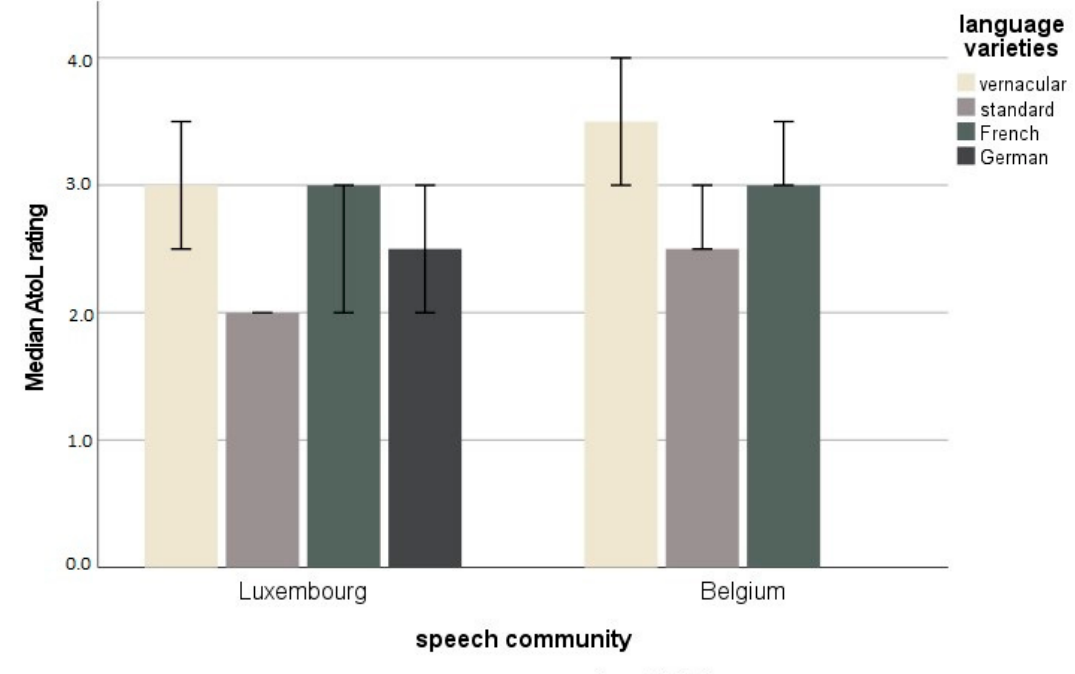
Figure 5. Between-speech community comparisons: Luxembourg (LUX) and Belgium (BELG). Vernacular (LUX: median = 3.00; BELG: median = 3.50). standard* (LUX: median = 2.00; BELG: median = 2.50). French* (LUX: median = 3.00; BELG: median = 3.00). German (LUX: median = 2.50; BELG: median = 2.50. Crosslinguistic contact variety* (LUX: German: median = 2.50; BELG: French median = 3.00). * sign. different between speech communities.